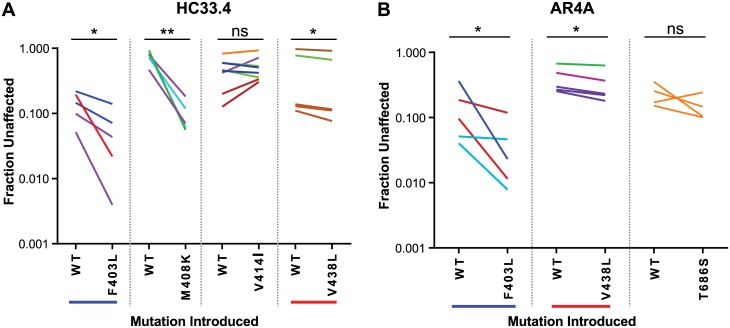
Reversion of naturally-existing resistance polymorphisms confirms their phenotype.Putative resistance polymorphisms that were already validated by introduction into neutralization sensitive E1E2 variants were reverted in other E1E2 variants where they were already naturally present. Wild type (WT) and mutated E1E2 variants were used to produce HCVpp, which were tested for neutralization by 10 μg/mL of HC33.4 (A) or AR4A (B). Fraction unaffected is the infection in the presence of 10 μg/mL of neutralizing antibody/infection in the presence of nonspecific IgG. Each mutation was introduced into 2–5 distinct E1E2 variants, except T686S, which could be introduced into only one E1E2 variant, and neutralization effect of each mutation was tested in at least 4 independent experiments performed in duplicate. Each line indicates an independent experiment comparing a WT HCVpp to the corresponding mutant version, and different colors indicate different E1E2 variants. Wild type (WT) and corresponding mutant HCVpp neutralization were compared by paired, two-sided T test. (ns, not significant; *, p<0.05; **, p<0.005).